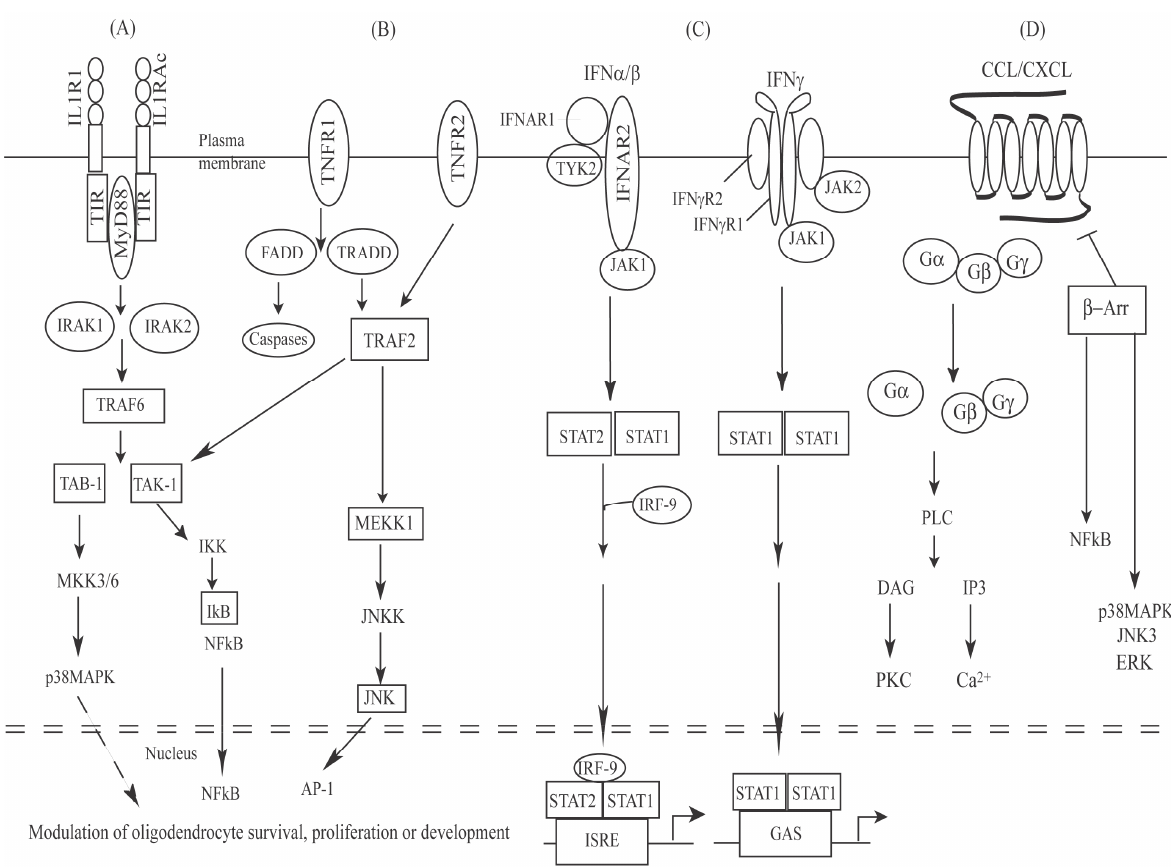
FIGURE 3. Schematic representation of signaling pathways utilized by chemokines and selected cytokine receptors. The cytokine receptors are related to the mechanisms by which each cytokine transmits intracellular signals. (A–C) Receptors for Th1 proinflammatory cytokines; the IFNs, TNF, and IL-1 are shown. Cytokine signaling events begin with receptor-ligand interaction at the plasma membrane, leading to the activation of kinases (JAK, IRAK, MEKK) and subsequent phosphorylation of substrates that bind specific downstream effectors, which eventually affect nuclear transcription factors (e.g., NF κ B) to control gene expression. (D) Chemokines signal through G-protein-coupled seven transmembrane receptors. Dissociation of G proteins (G α , G βγ ) signals to downstream effectors phospholipase C (PLC), diacylglycerol (DAG), protein kinase C (PKC), inositol 1,4,5-trisphosphate (IP3), beta-arrestin ( β -Arr), extracellular signal-regulated kinase